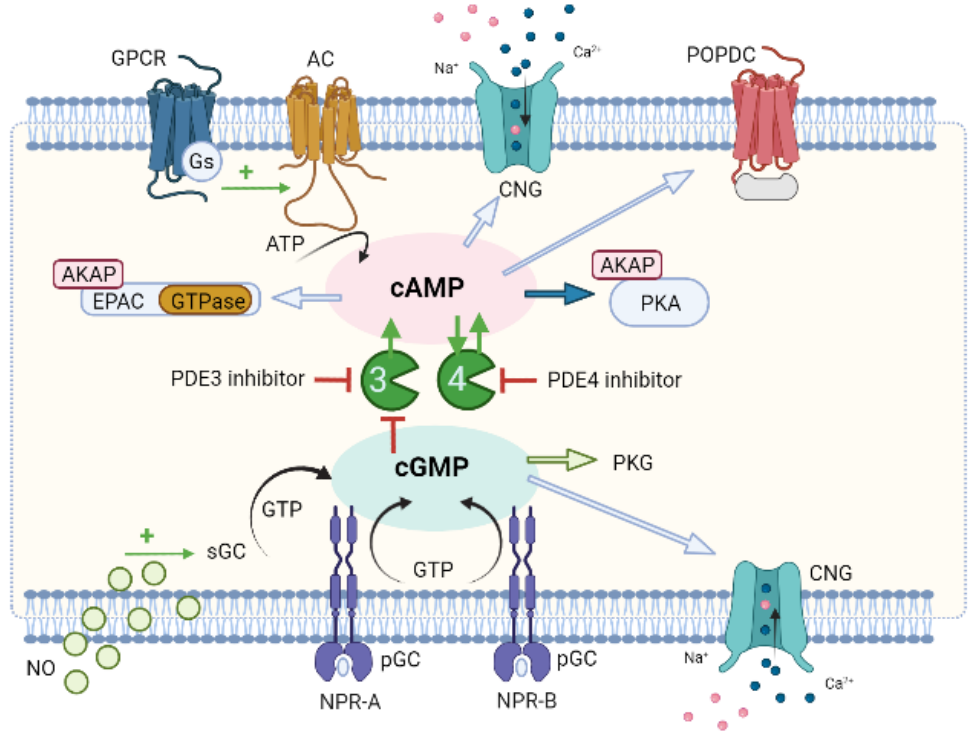
Figure 4. Schematic representation of crosstalk cAMP/cGMP signaling mediated by cyclic nucleotide phosphodiesterases (PDEs) (created with biorender.com). In vascular SMCs, NO induces crosstalk mechanism between PDE3 and PDE4 that mediates